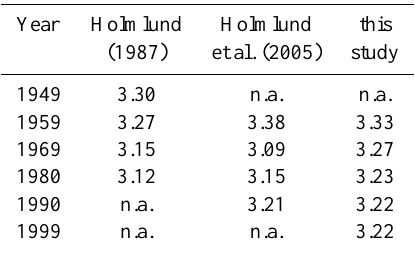
Table 6. Areal extent of Storglaci¨aren as published in different stud-